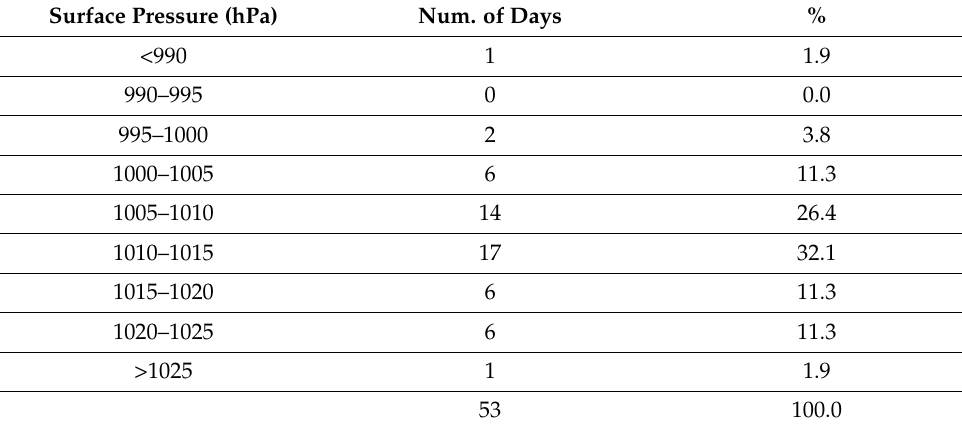
Table 4. Distribution of surface atmospheric pressure on days with torrential rain in the Balearic Islands